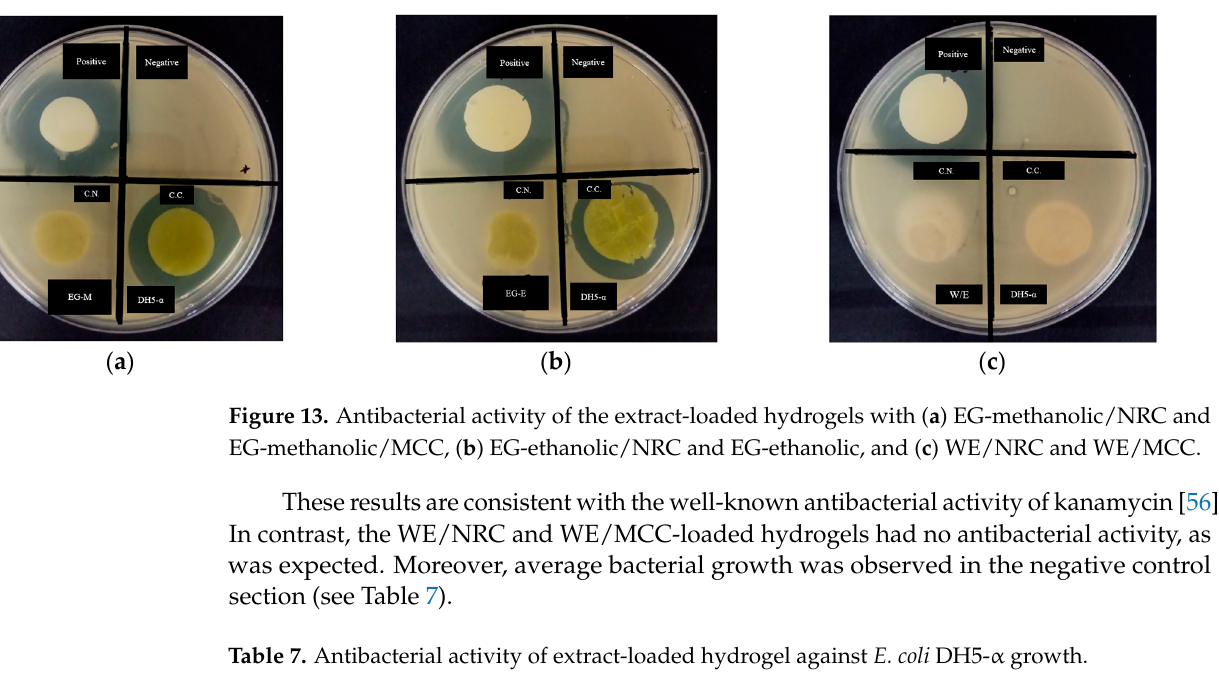
Table 7. Antibacterial activity of extract-loaded hydrogel against E. coli DH5- α growth. Diameter (cm) Plant Extract /NRC /MCC